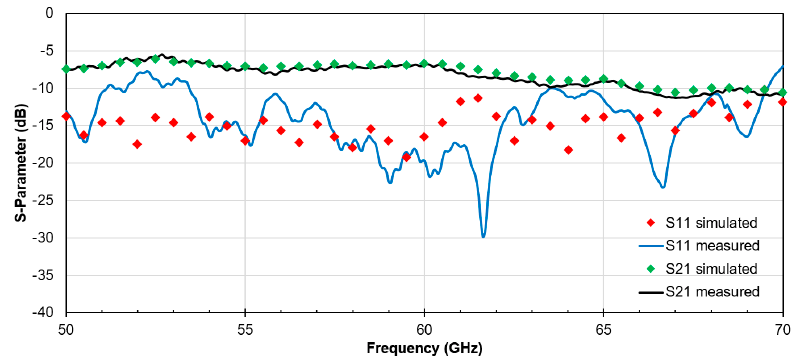
Figure 5. Scattering parameters of the SIW LWA in dB over the frequency range from 50 to 70 GHz. The simulated values of S 11 (red, diamonds) and S 21 (green, diamonds) are shown together with the de-embedded measured values of S 11 (blue, solid line) and S 21 (black, solid line).